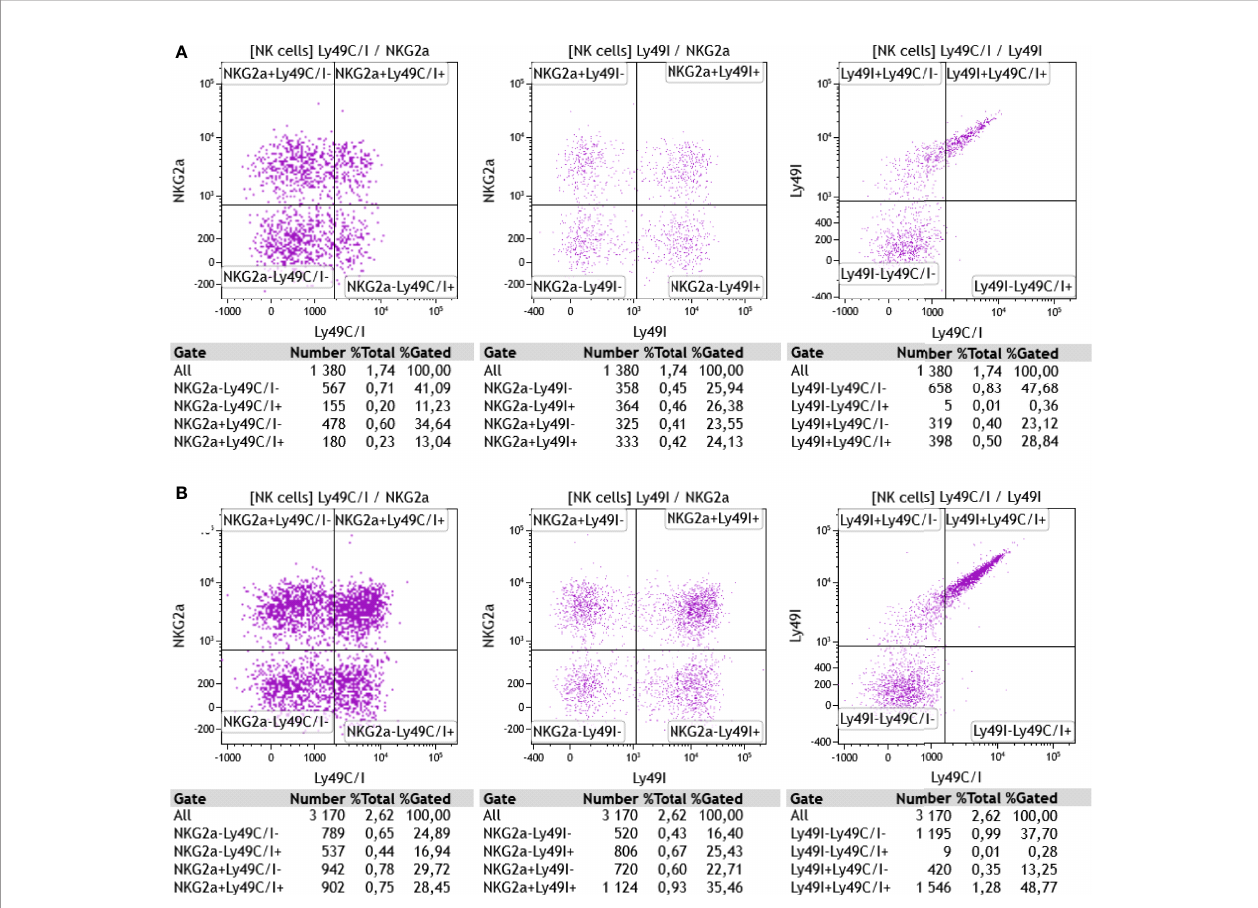
FIGURE 7 | (A) Ex vivo staining of CD3-NK1.1+ splenocytes from a wildtype B6 mouse with anti-NKG2A B6 (clone16a11), anti-Ly49C/I (clone 5E6), and anti-Ly49I (clone YLI-90) monoclonal antibodies. (B) Same antibodies used for the staining of splenocytes from a TAP1-KO littermate. One representative experiment out of two is shown (n=2). Particularly in the wildtype cells, the discrimination of Ly49C/I+ NK cells from the Ly49C/I- population is suboptimal, which might be explained, at least in part, by a competitive effect of the YLI-90 antibody for epitopes shared with 5E6. In the TAP1-KO mouse, the MFI of Ly49I on NK cells expressing this receptor is higher than in the B6 wildtype, suggesting that Ly49I, similar to Ly49A and Ly49C for example, tries to adapt to the missing MHC class I molecules through